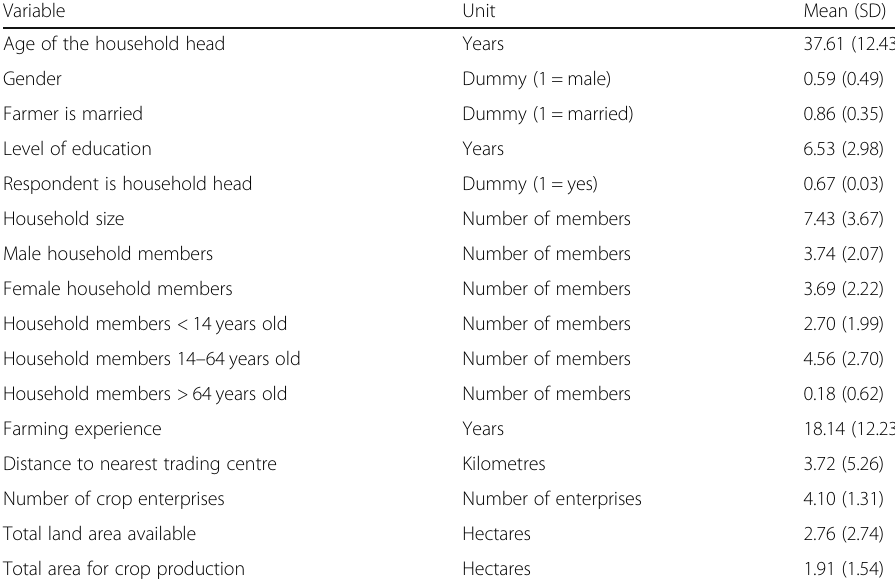
Table 1 Socioeconomic characteristics of the